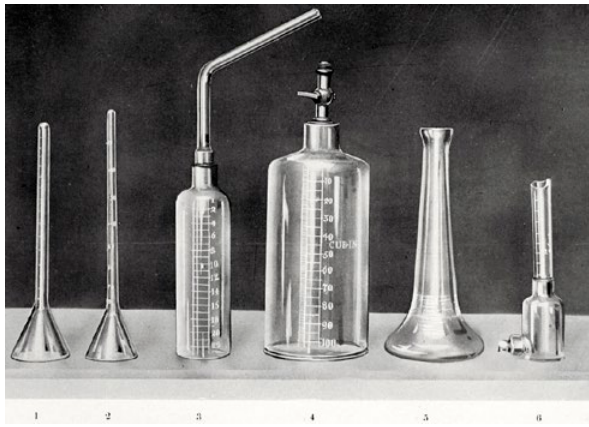
Figure 4. Apparatus that belonged to Dalton. 29 1 , 2 . Glass funnels with long graduated stems closed at the ends used by Dalton as eudiometrical tubes. 3 . Graduated bell jar with bent tube attached for collecting and measuring gases. 4 . Graduated bell jar with brass cap and stopcock for measuring gases. 5 . Conical glass vessel con- taining mercury. 6 . A fragment of Hope’s eudiometer. From Mem- oirs and Proceedings of the Manchester Literary & Philosophical Soci- ety , 1904, Vol. 48 (No. 22), plate